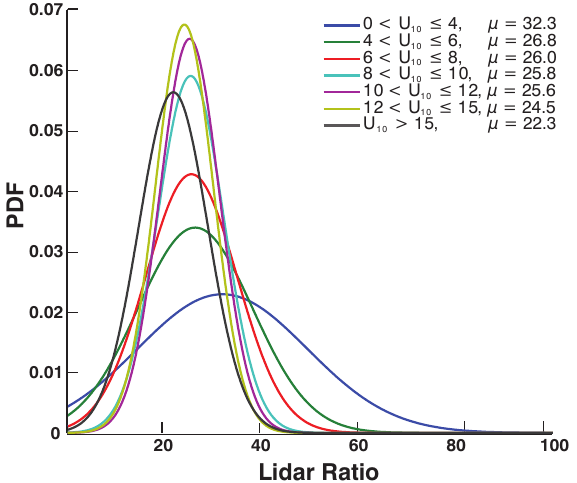
Figure 5. Probability density function of clean marine aerosol lidar ratio for selected AMSR-E wind speed regimes. The mean ( µ) of each distribution is also